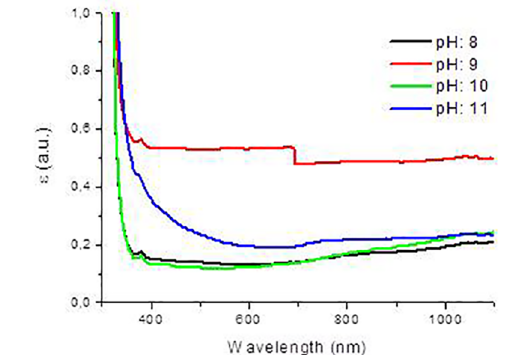
Figure 7. Plot of dielectric constant of MnSe films at different pHs.